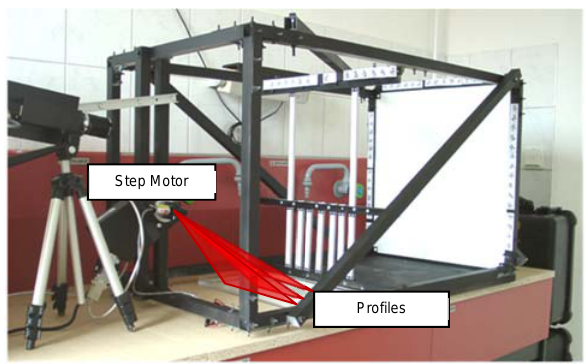
Figure 13: System layout with step motor.